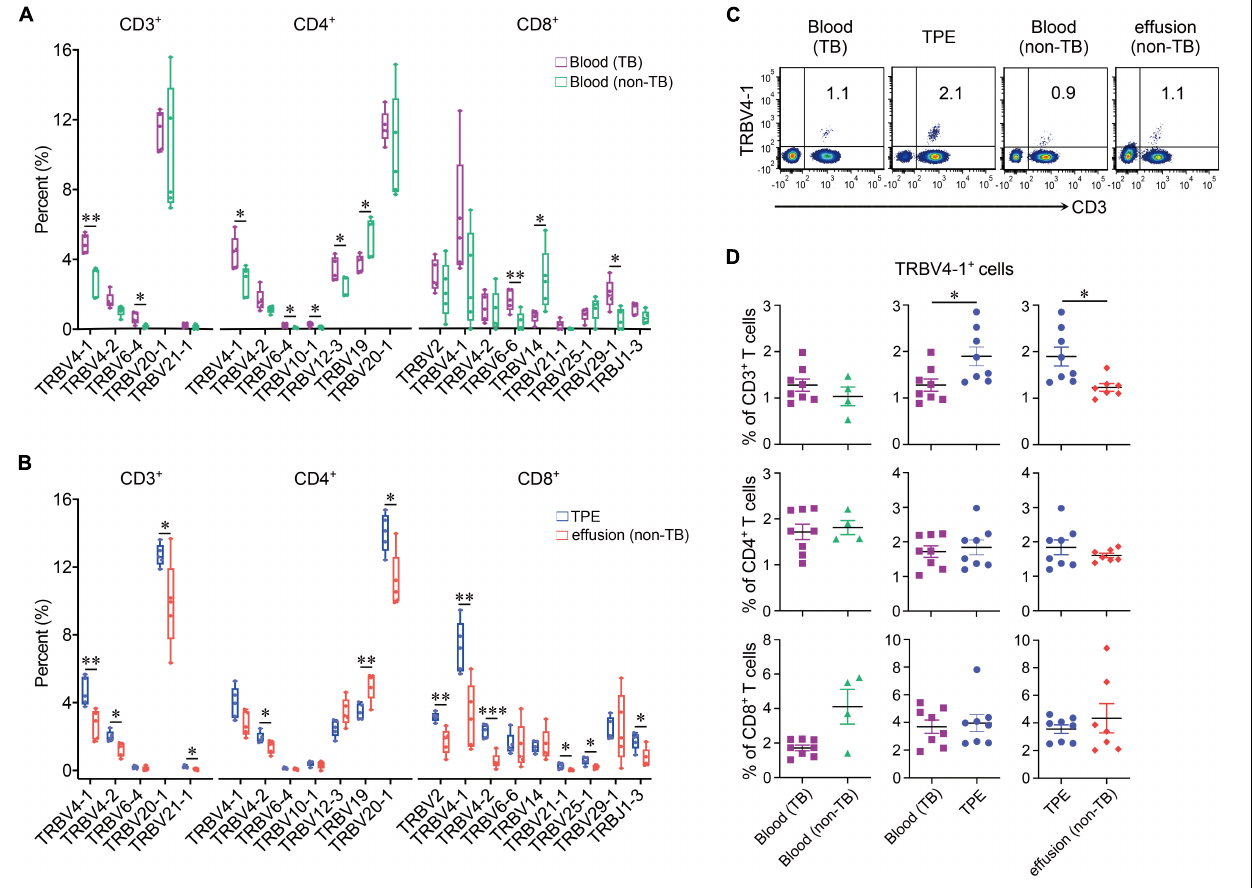
FIGURE 2 | Differential expression of TRB V and J genes in blood and pleural samples from TPE patients and non-TB effusion patients. (A) Comparison of usage of TRBV and TRBJ genes in blood between TPE patients and non-TB effusion patients from the single-cell seq data. (B) Comparison of usage of TRBV and TRBJ genes in pleural effusion between TPE patients and non-TB effusion patients from the single-cell seq data. (C) The representative flow cytometric dot plots of TRBV4-1 + CD3 + T cells in pleural effusion and paired blood from TPE patients and non-TB effusion patients. (D) The protein expression of TRBV4-1 in T cell subsets in pleural effusion and the paired blood from TPE patients and non-TB effusion patients by flow cytometry. Data are presented as means ± SEM. ∗ P < 0.05, ∗∗ P < 0.01, ∗∗∗ P < 0.001, determined by Mann-Whitney U test. TPE, tuberculous pleural effusion; non-TB,